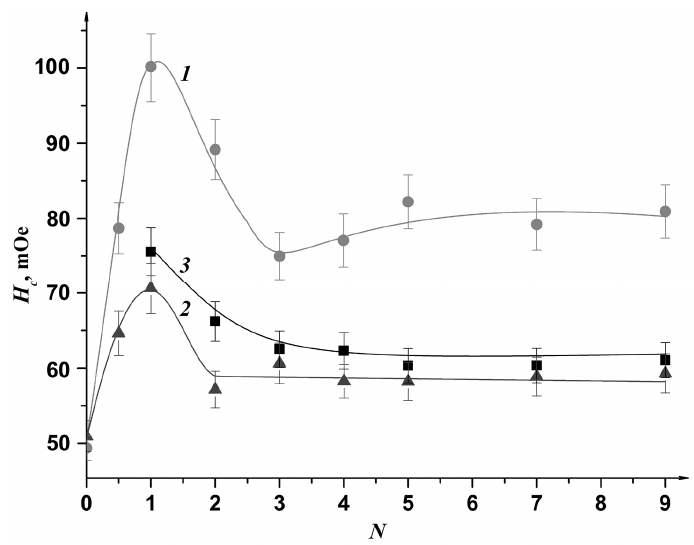
Figure 10. Coercive force as a function of the degree of deformation upon HPT: 1 –Fe 53.3 Ni 26.5 B 20.2 AA; 2 –Co 28.2 Fe 38.9 С r 15.4 Si 0.3 B 17.2 AA; 3